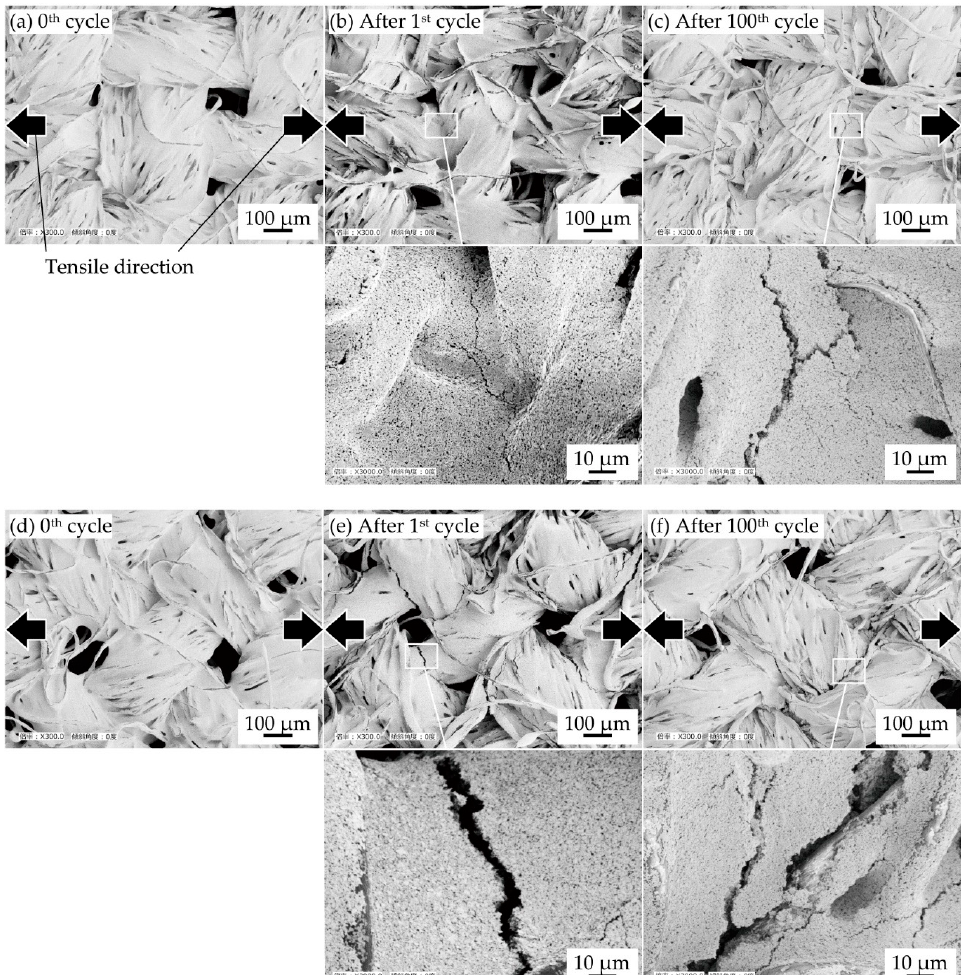
deformation. Pattern width of 1.4 mm with horizontal weave ( a ) before stretching, after ( b ) the 1 st cycle and ( c ) 100 th cycle. Pattern width of 1.4 mm with diagonal weave ( d ) before stretching, after ( e ) the 1 st cycle and ( f ) 100 th cycle.